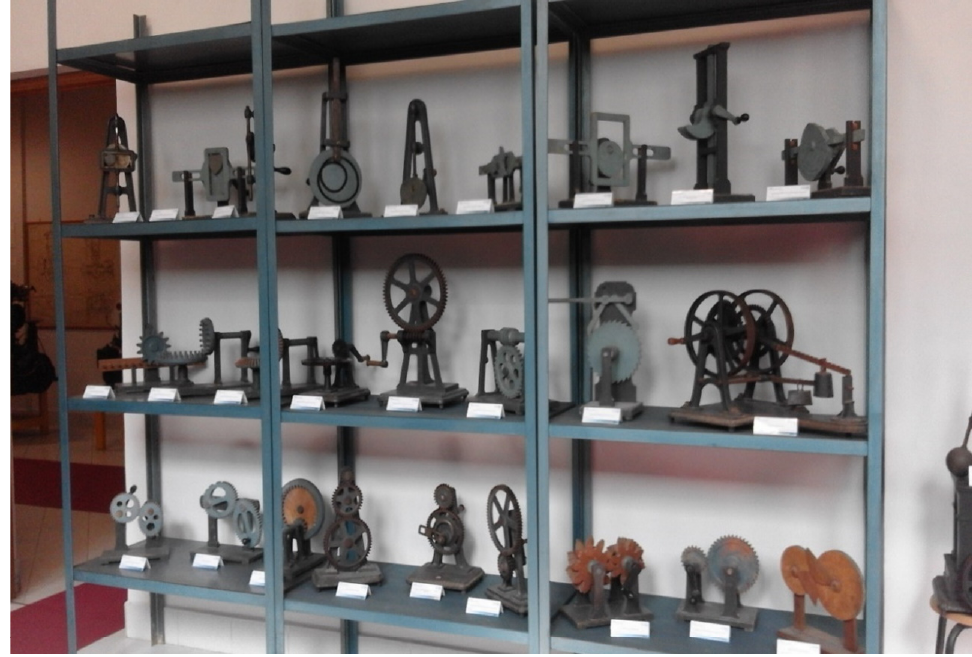
Figure 21. A cabinet with open-air exhibition of mechanism models in a museum room specifically dedicated to the models for teaching.